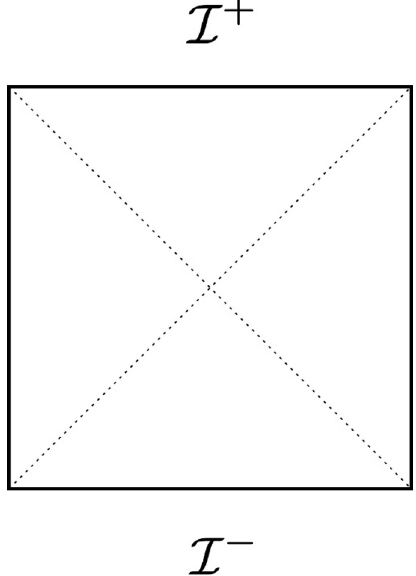
Figure 11 . The Penrose diagram for dS 3 . The (cid:13)uctuating spatial boundaries at past and future in(cid:12)nity are depicted in